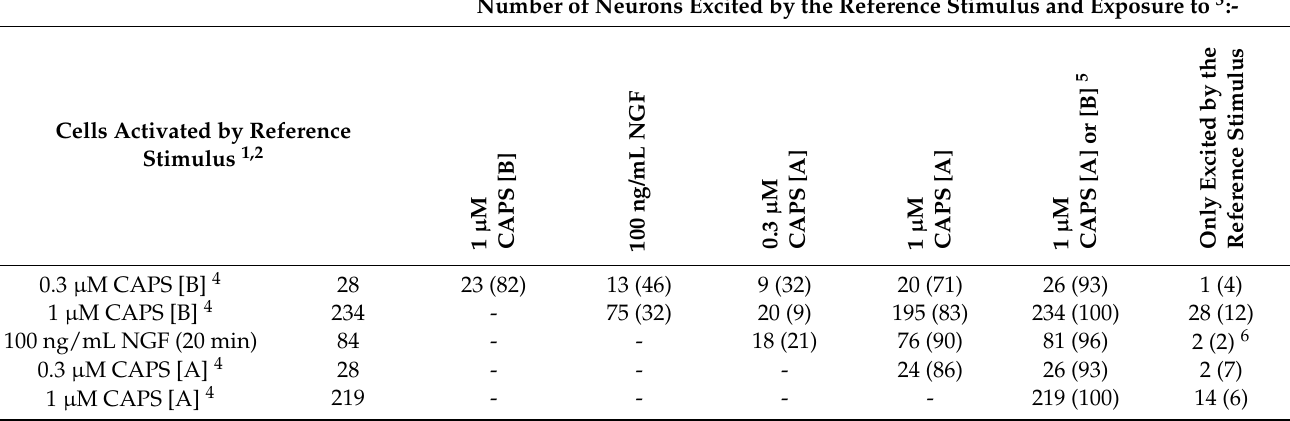
Table 1. Quantification of DRGNs excited by sequential exposure to CAPS and NGF. Number of Neurons Excited by the Reference Stimulus and Exposure to 3